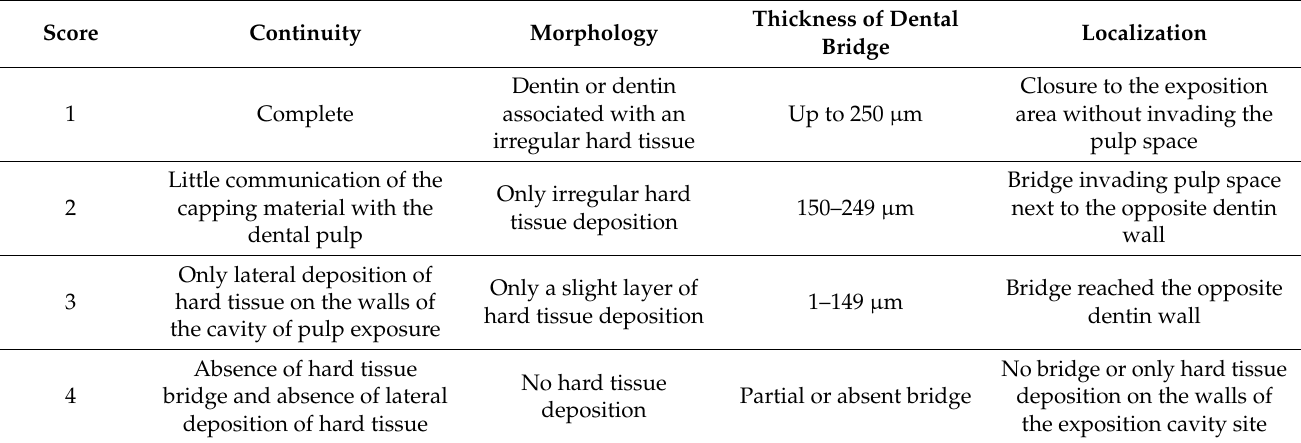
Table 2. Evaluation parameters and scores used for hard tissue bridge formation (continuity, morphology, thickness of dental bridge, and localization).